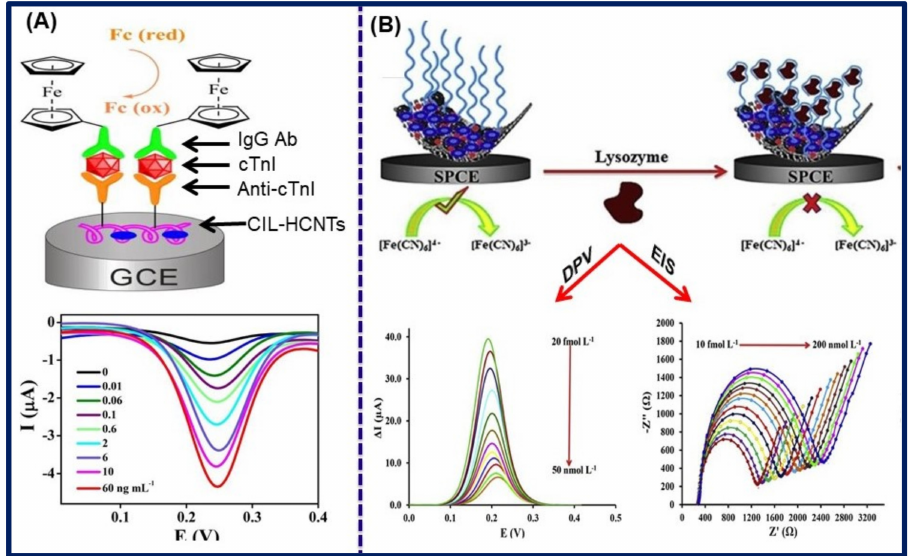
Figure 13. Schematic illustration of the ( A ) fabricated electrochemical immunosensor for cTnI. Reprinted with permission from Ref. [121]. Copyright 2018, Elsevier. ( B ) Step-by-step preparation of SPCE/Amino-RGO/ILs/Amino-MSNs/APT. Reprinted with permission from Ref. [145]. Copyright 2019,